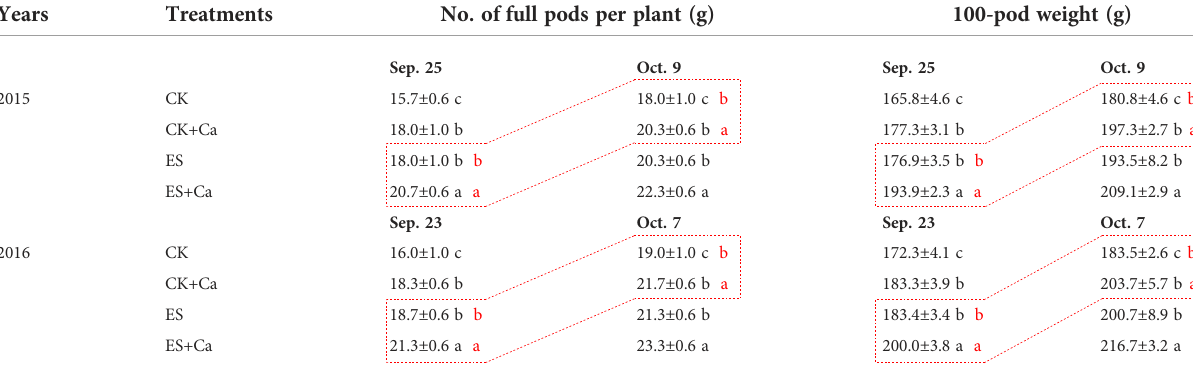
TABLE 1 Effects of exogenous foliar calcium (Ca 2+ ) application on the number of full pods per peanut plant and the 100-pod weight under early and normal sowing scenarios in 2015 and 2016. Years